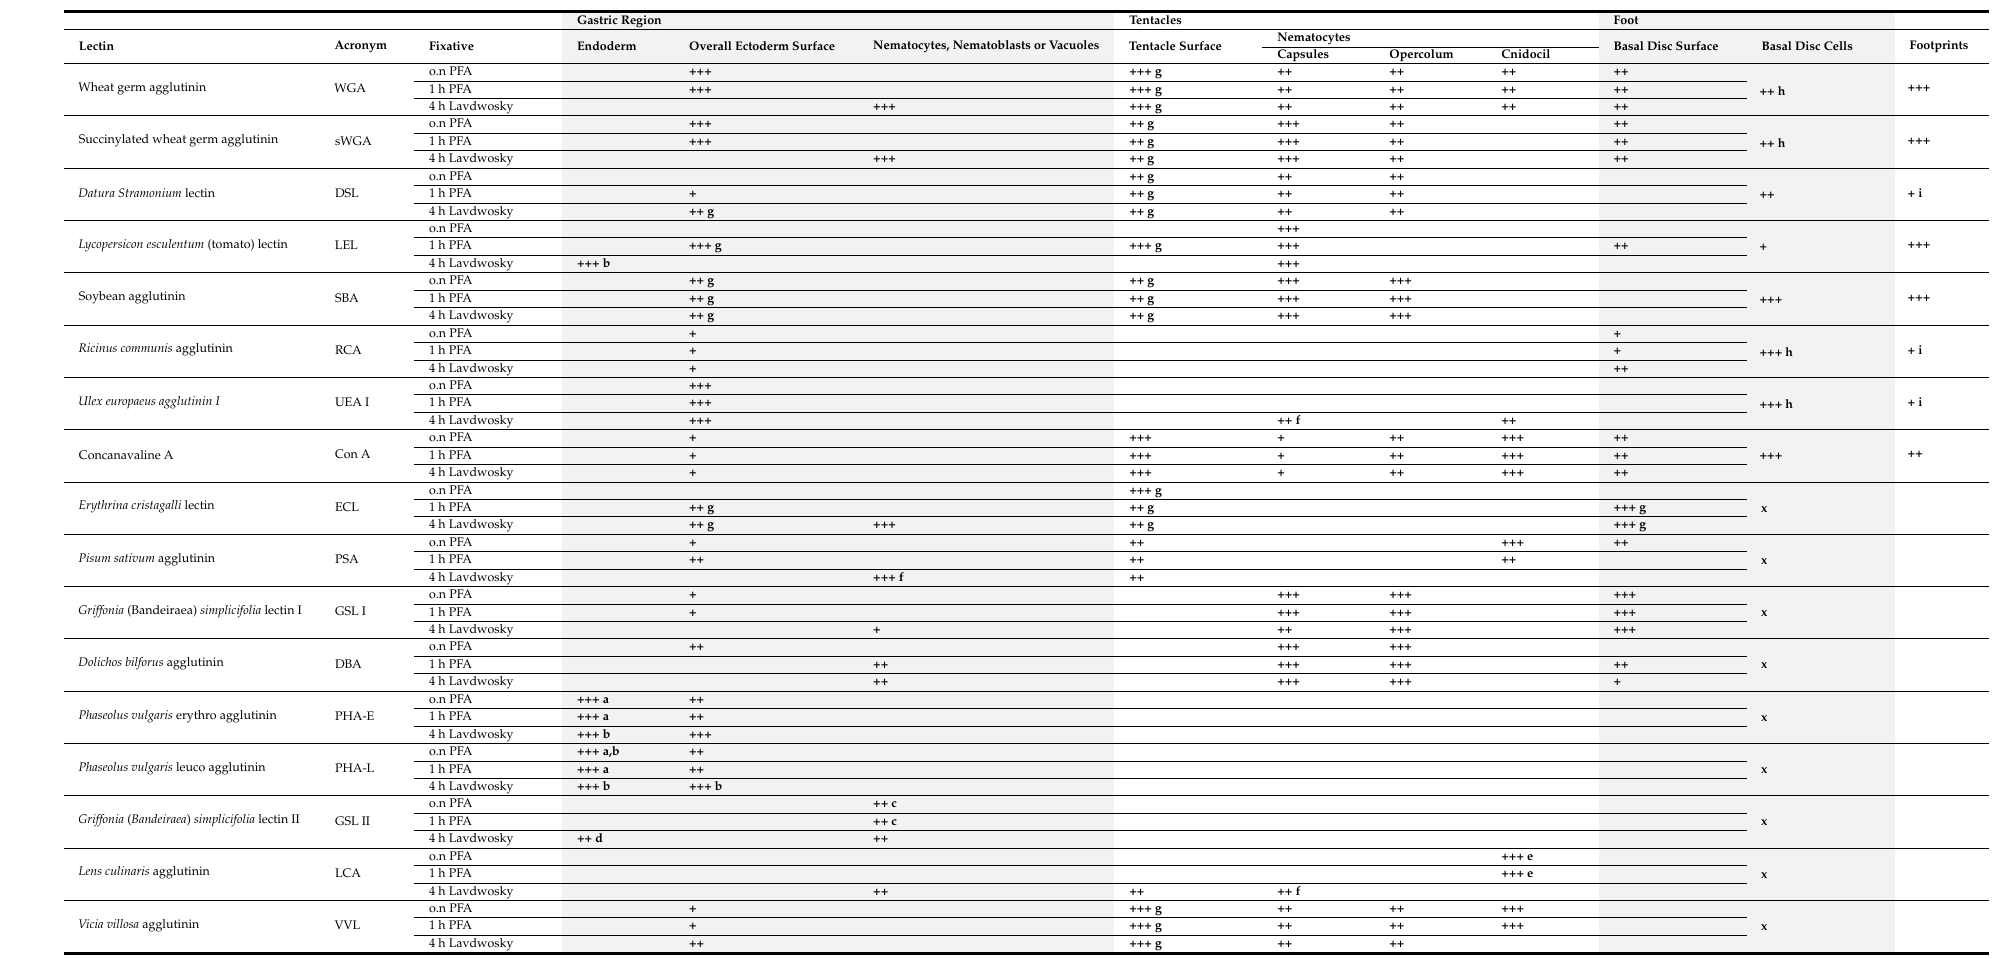
Table 1. Overview of lectin labeling in Hydra whole-mounts, basal disc cells, and footprints. +++, strong labeling, ++ intermediate labeling, + weak labeling, X not performed. a—patchy staining, associated with muscle fibers; b—cell membranes; c—subcellular structures; d—gland cells in the hypostome of developing buds; e—base of cnidocil; f—erupted nematocytes’ tubules; g—dot-like; h—secretory granules; i—variant intensity among individual